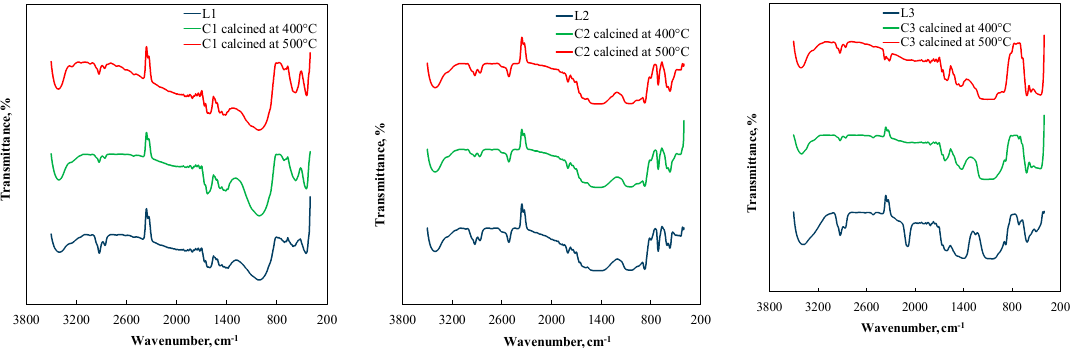
Figure 1. Fourier transform infrared spectroscopy (FTIR) spectra of galvanic sludge and catalytic material.